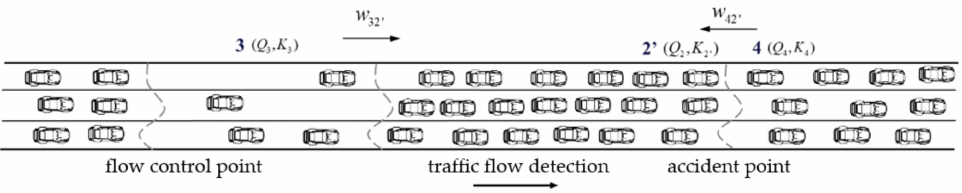
Figure 9. Diagram of flow density after traffic accident clearance in the extra-long tunnel.